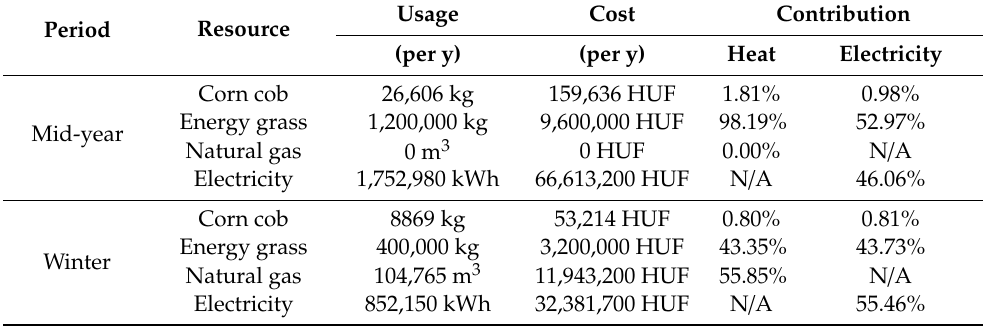
Table 10. Energy supply overview for the optimal solution in the multi-periodic model. Period